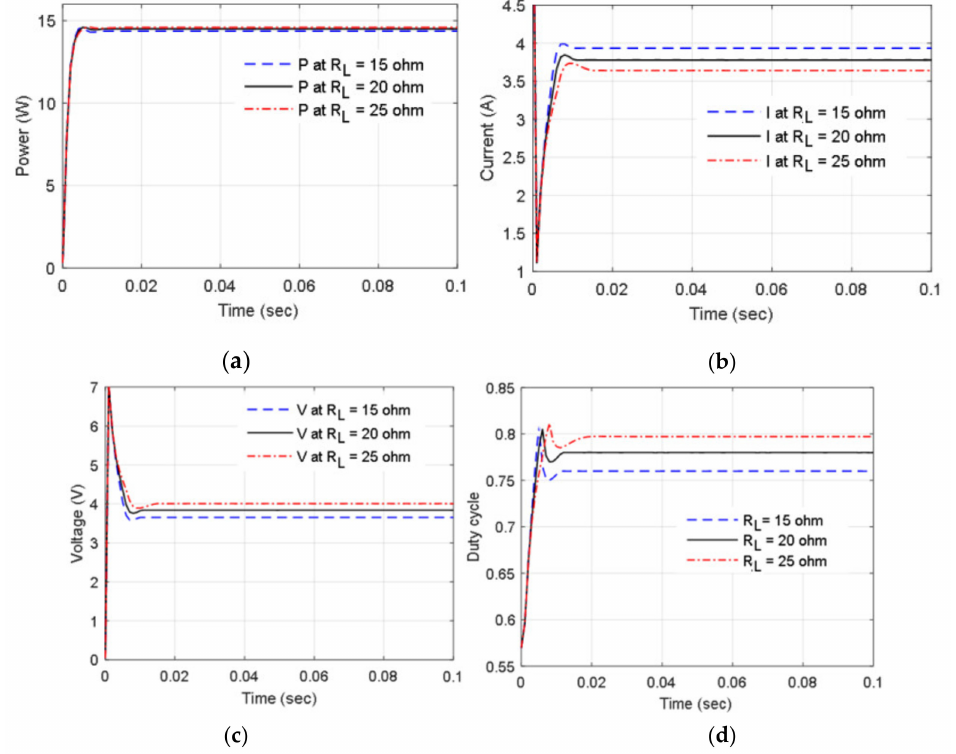
Figure 13. TEG performance using VFOFLC-based MPPT for the di ff erent load: ( a ) power output; ( b ) current flow; ( c ) voltage output; ( d ) duty